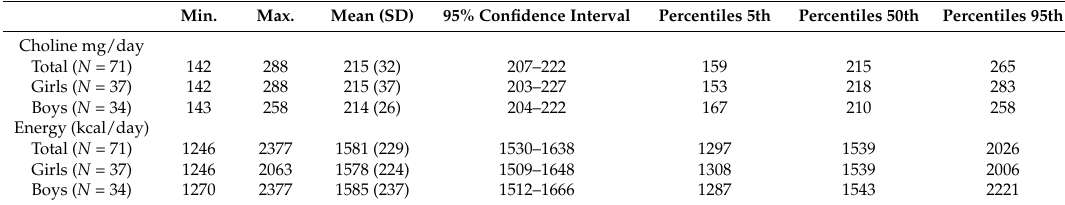
Table 1. Total choline and energy intake.